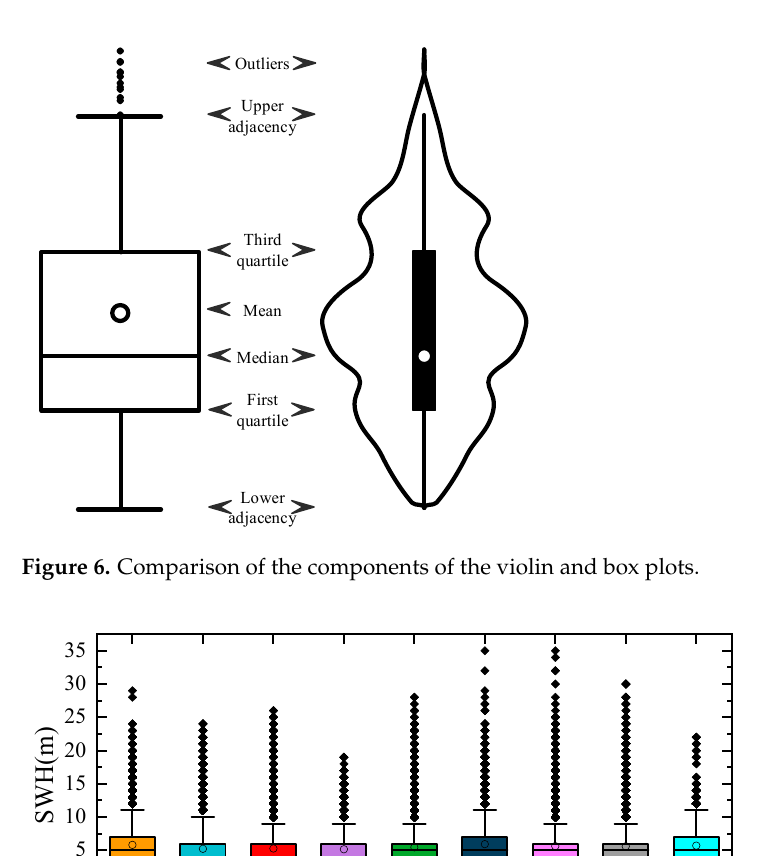
Figure 6. Comparison of the components of the violin and box plots.